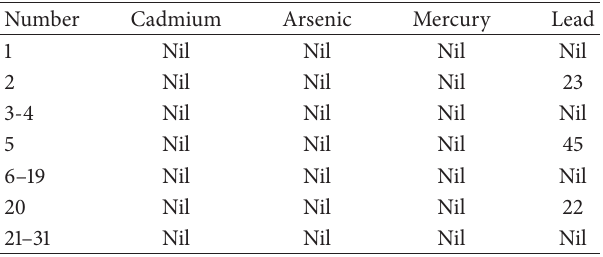
Table 4: Heavy metal of the mixtures